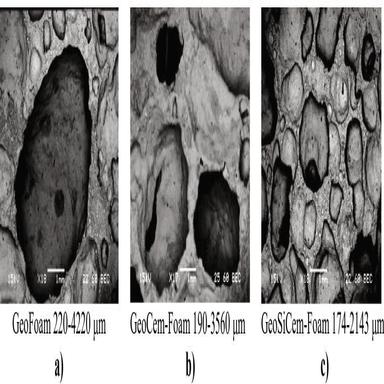
Scanning Electron Microscopy images of geopolymer foam boards for a) GeoFoam, b) GeoCem-Foam and c) GeoSiCem-Foam (S/L: 3.5 g/mL, 8 M KOH, Al powder addition: 15 wt %, Curing: 24 h at 70 ◦C).